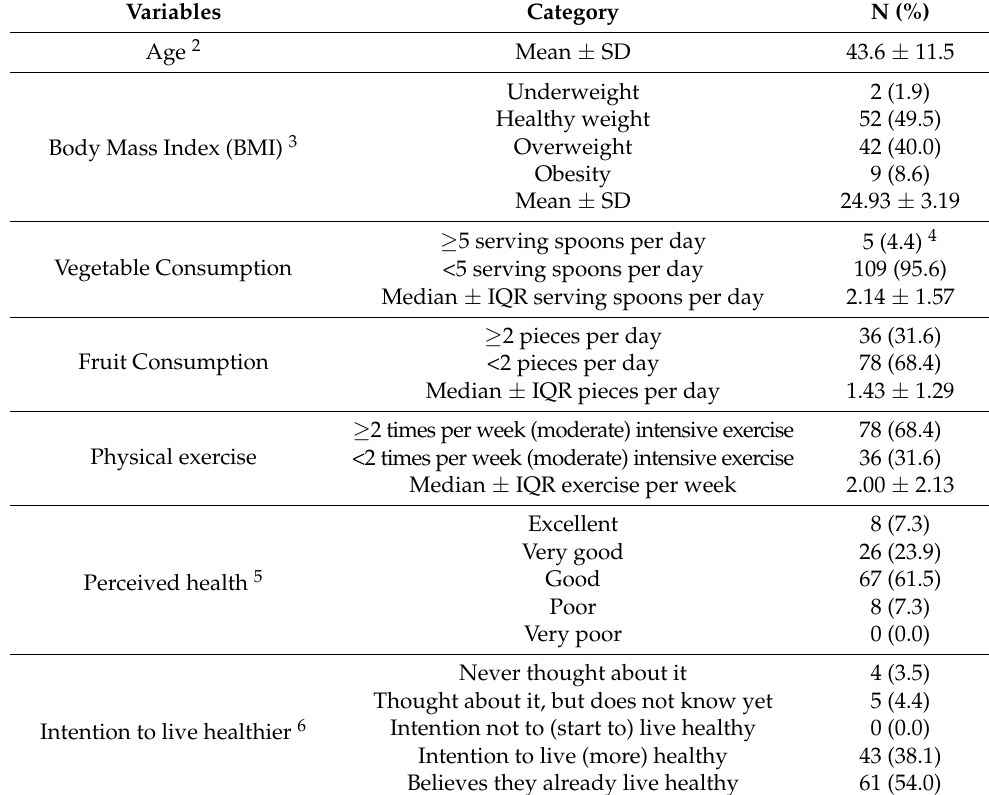
Table 1. Characteristics of the study population at baseline 1